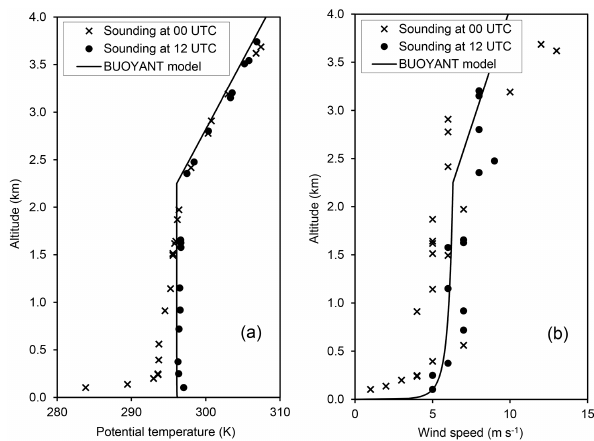
Figure 4. Vertical profiles of potential temperature and wind speed, both measured at the observatory of Jokioinen on 26 June 2009 at 00:00 and 12:00UTC, and the modelled profiles at